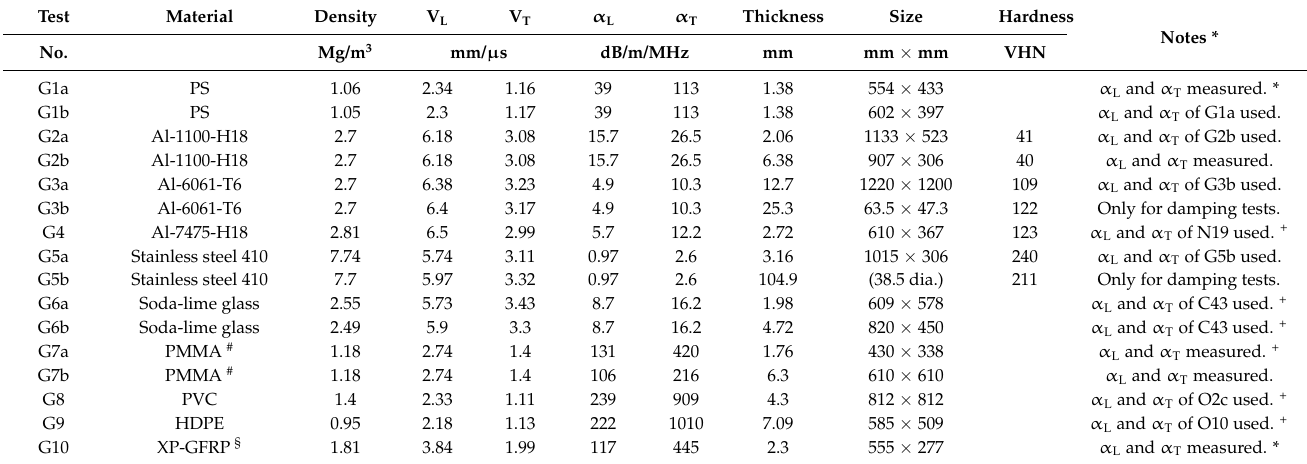
Table 1. Tested materials and their properties.